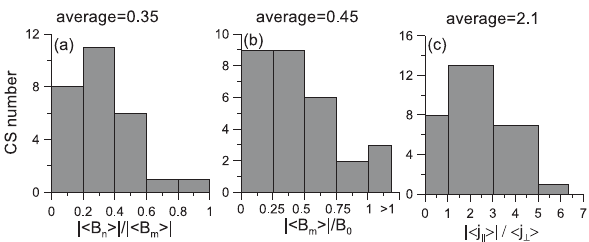
Fig. 6. Panels present distributions of absolute values of ratios B n /B m (a) , B m /B 0 (b) and h j k i / h j ⊥ i (c) . The averaged values (over all 29 CSs) are shown at the top.